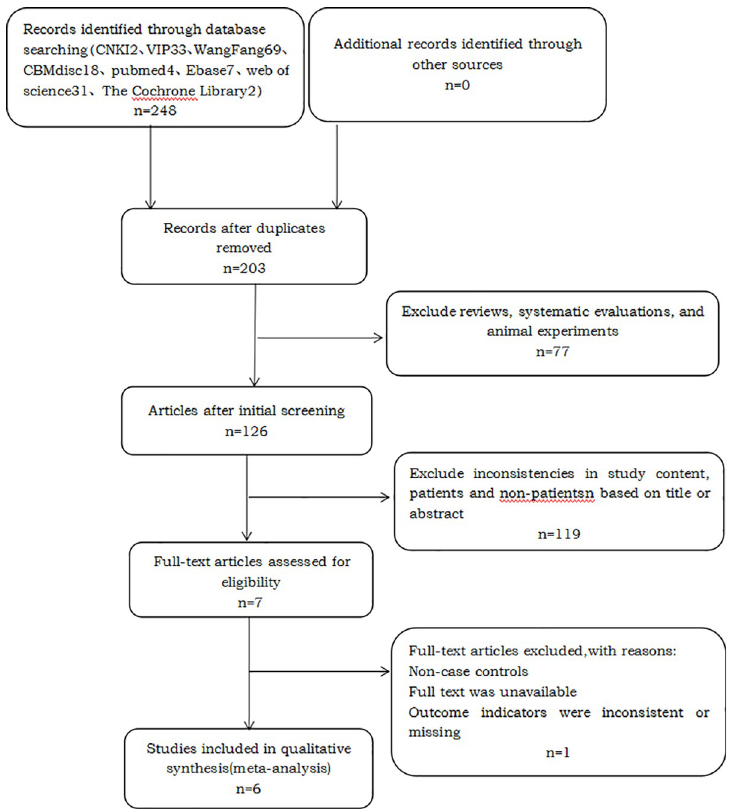
Fig 1. Flow chart of the search